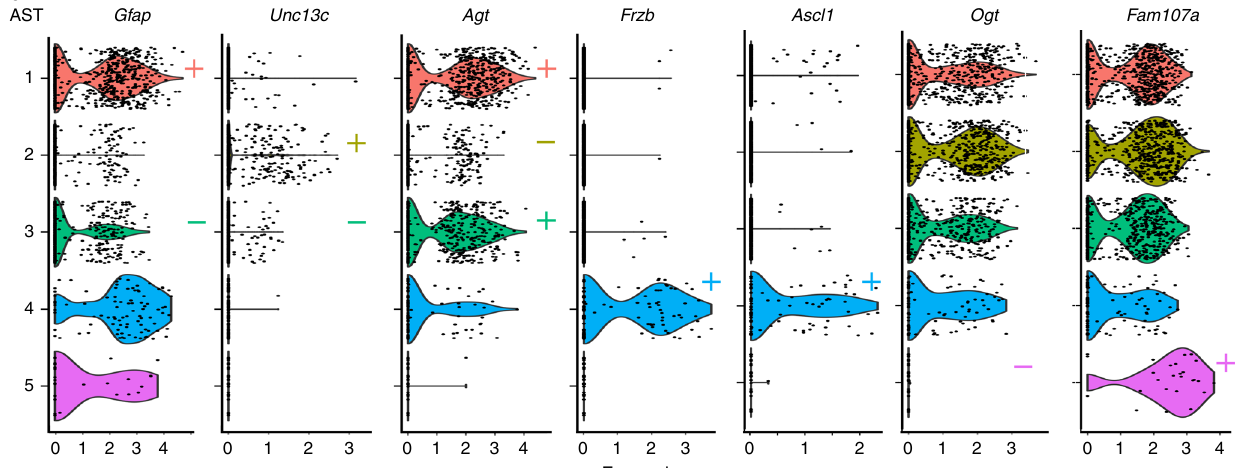
(Supplementary Data 1 and https://holt-sc.glialab.org/sc/), these data con fi rmed that our protocol could identify both inter- and intra-regional heterogeneity of astrocytes in adult mouse brain.